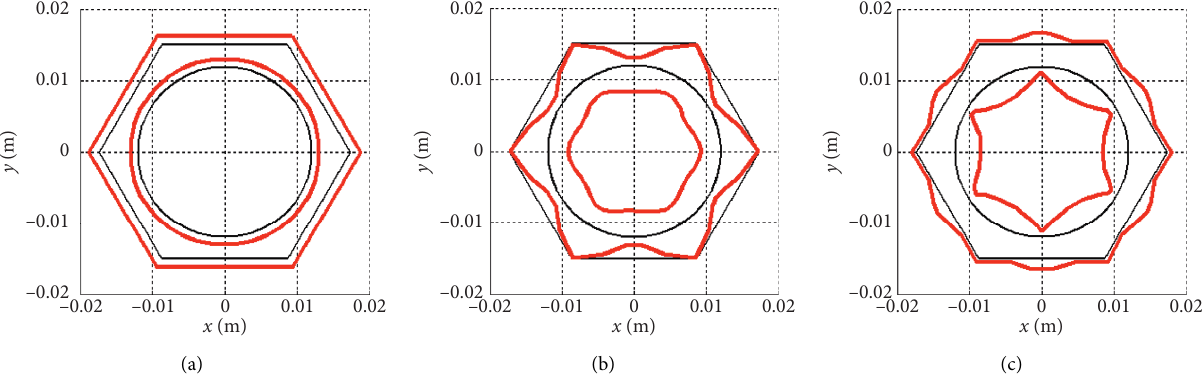
Figure 4: The first three longitudinal mode shapes in the hexagonal pipe: (a) L (0, 1) mode, (b) L (0, 2) mode, and (c) L (0, 3)